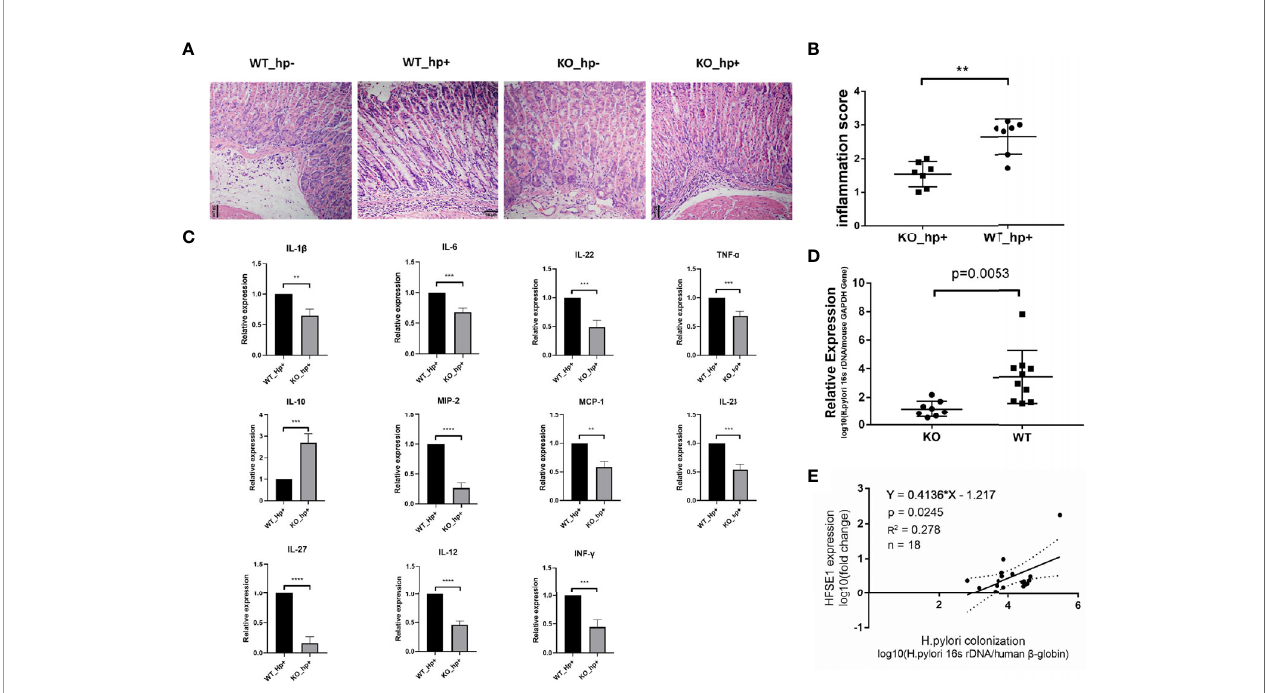
FIGURE 2 | Heparanase facilitates the in fi ltration of macrophages in a model of chronic gastritis. WT and Hpa-KO mice were inoculated with H. pylori as described in Figure 1 . Gastric tissues were harvested after 8 weeks and 5-micron sections were subjected to H&E staining (A) . The in fl ammatory score, evaluated by two independent expert pathologists, is shown in (B) . Total RNA was extracted from another portion of the tissues (WT mice n = 3, KO mice n = 3) and subjected to qPCR analyses applying primer sets speci fi c for the indicated cytokine (C) . (D) Colonization of H. pylori in WT and Hpa-KO gastric tissue (WT mice n = 7, KO mice n = 7). The relative amounts of the 16S rRNA gene of H. pylori and the mouse beta-globin gene were quanti fi ed by qPCR. Note the low abundance of H. pylori in chronic gastritis of Hpa-KO mice (WT mice n = 10, KO mice n = 8). (E) Correlation between heparanase expression and the colonization of H. pylori in human samples. Human chronic gastritis and intestinal metaplasia tissues infected with H. pylori were collected during gastroscopy examination (chronic gastritis n = 11, intestinal metaplasia n = 7). One portion of the gastric mucosal tissue was used to extract the total DNA. The relative amounts of the 16S rRNA gene of H. pylori and the human beta-globin gene were quanti fi ed by qPCR. The other portion of the gastric mucosal tissue was used to extract the total RNA. The relative expression of human heparanase mRNA and human beta-globin mRNA was determined by qRT-PCR. **p <0.01; ***p <=0.001; ****p